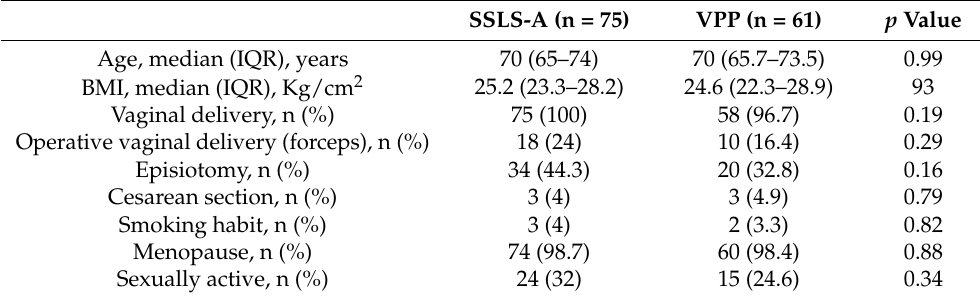
Table 1. General characteristics of the study population.